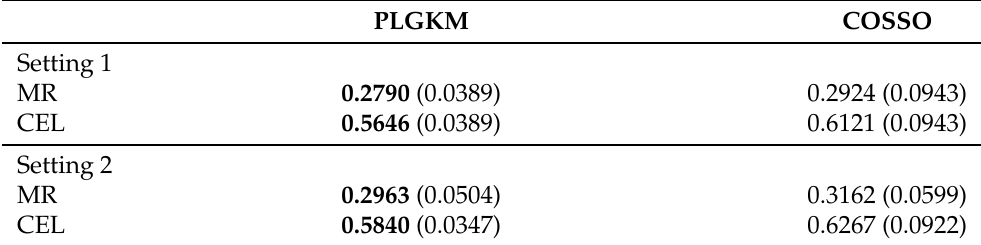
Table 3. MR and CEL of PLGKM and COSSO with standard deviations in